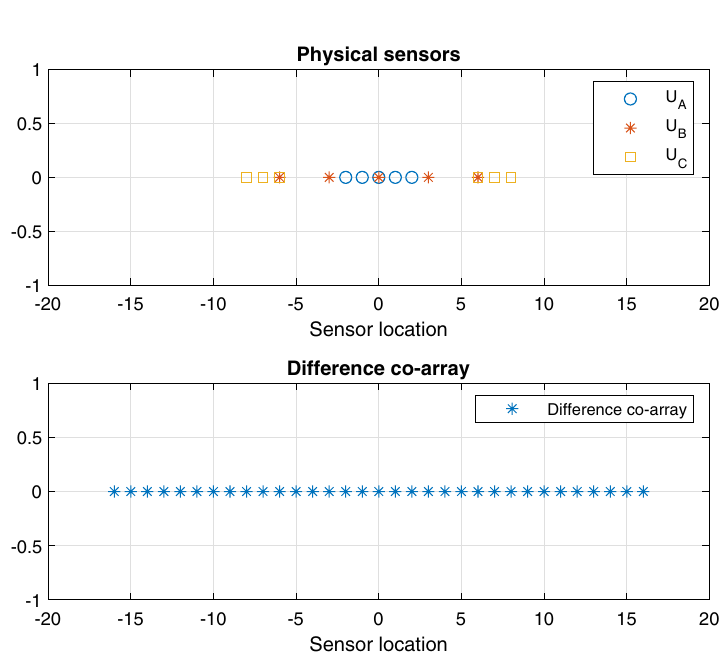
Fig. 2 Extended sparse convolutional array of (3,